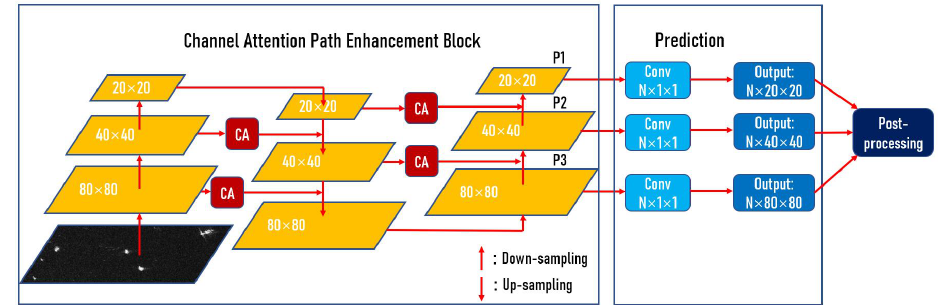
Figure 6. Structure of CAPE-Block and prediction.